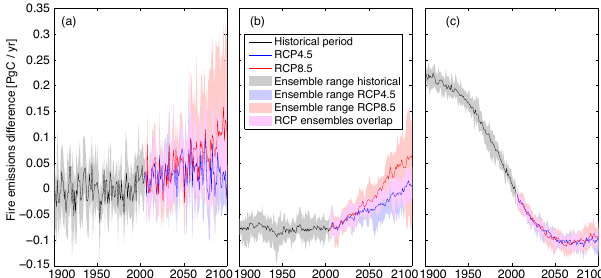
Figure 2. Effects of different factors on global emissions for his- torical change (until 2005) and two future climate change scenarios (RCP4.5 and RCP8.5). (a) Effect of climate change, (b) effect of changing atmospheric CO 2 , (c) effect of changing human popula- tion density. All simulations are for the central SSP2 population scenario. Solid lines for ESM ensemble means and shaded areas for the range across eight ESM simulations each.